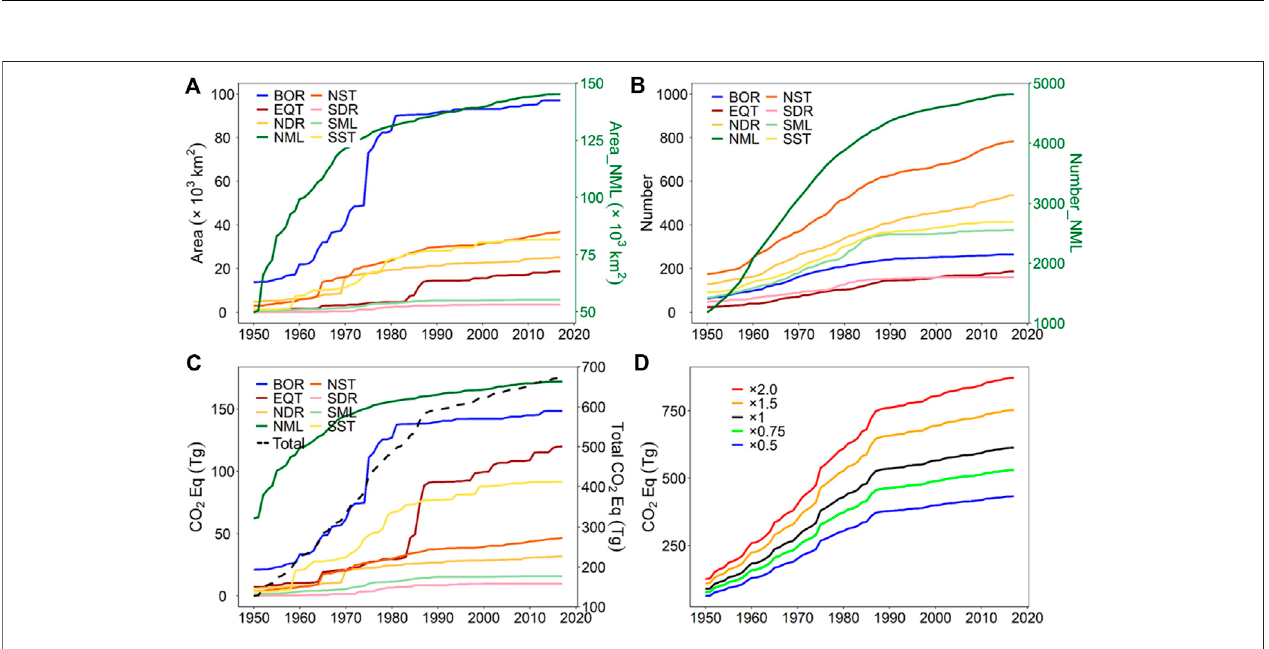
FIGURE 5 | Long-term evolution of global reservoir surface area (A) , numbers (B) , estimated GHG emissions in different hydrobelts [ (C) , black dotted line represents the total CO 2 Eq], and GHG emissions calculated from global reservoirs under different TP concentrations (D)